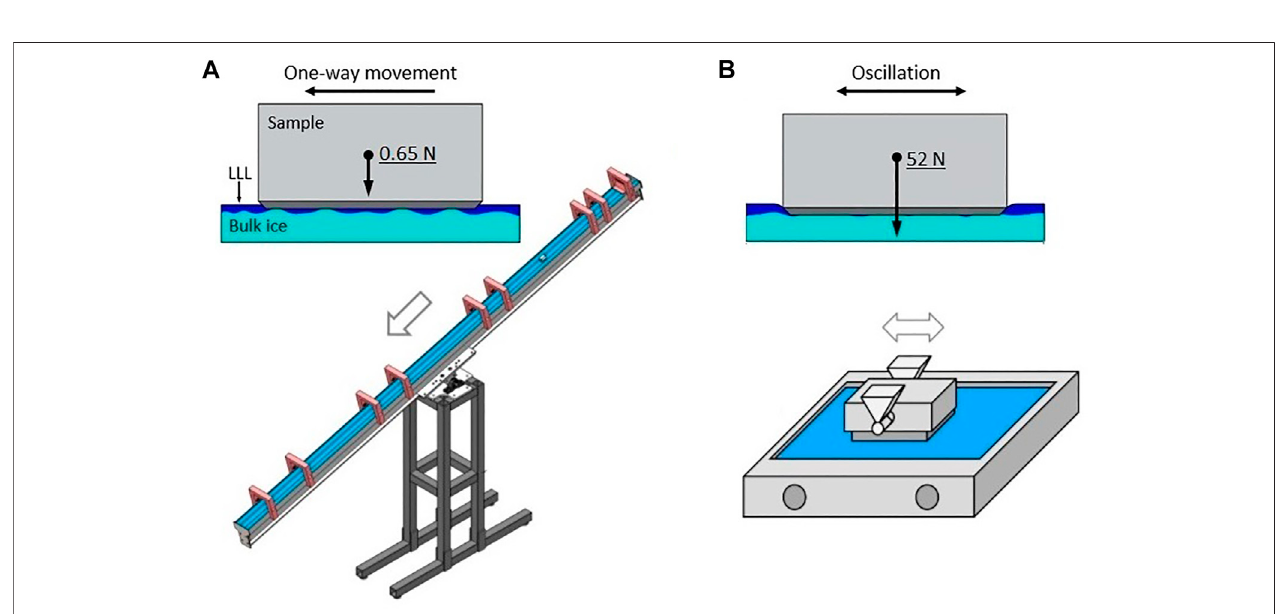
FIGURE 7 | A schematic representation of the test setups used: (A) inclined plane tribometer that ensures sample sliding in one direction down the plane without any additional load on the samples. The velocity of freely sliding samples was measured using eight optical sensors. Higher measured sample velocity indicates better sliding ability, (B) oscillating tribometer. The sample oscillates on the ice surface with an additional applied normal load of 52 N. Since the sample oscillates with high frequency on the same ice surface, the ice surface is slightly melted, allowing the sample to penetrate deeper into the ice surface. Additionally, the melted ice may work as a lubricant. More information about the test setups can be found elsewhere (Velkavrh et al., 2019).